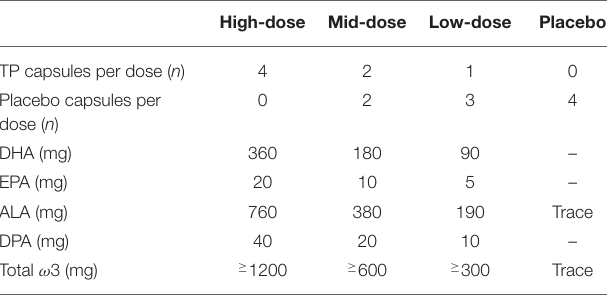
TABLE 1 | Study products consumed in each study group. High-dose Mid-dose Low-dose